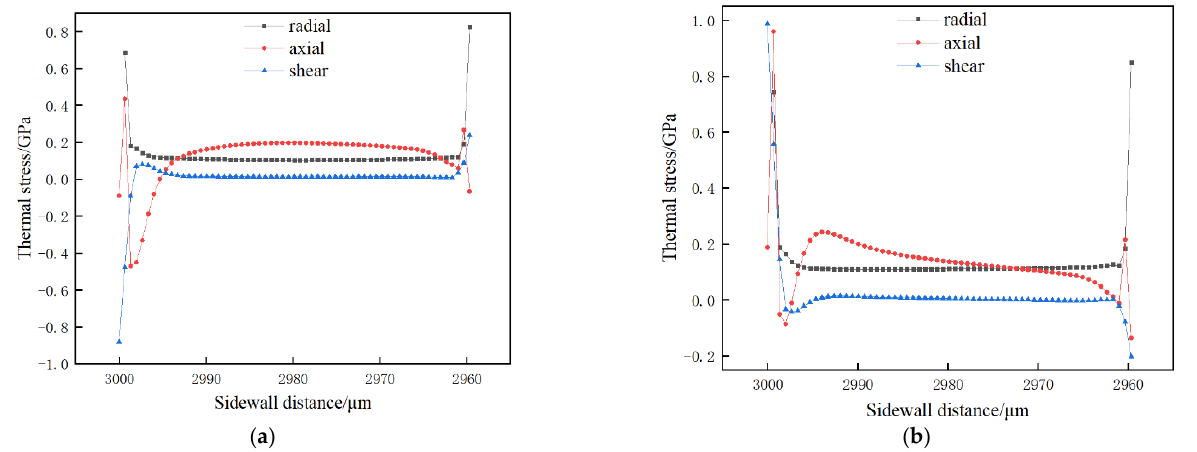
Figure 9. Distribution of thermal stress along the depth of the sidewall, ( a ) Left sidewall, ( b ) Right sidewall of the M2S2 crack at the “maintained at 1200 °C” situation.